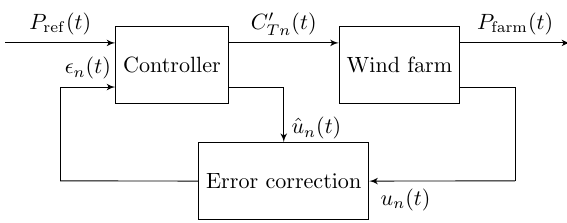
Figure 2. Block diagram of the controlled wind farm system for both controllers. Each controller computes a thrust coefficient com- mand signal C (cid:48) ( t ) using the reference signal P ref ( t ) and an error T n correction term (cid:15) n ( t ). The error correction is computed using the measured velocity u n ( t ) and the predicted velocity ˆ u n ( t ) from the underlying wake